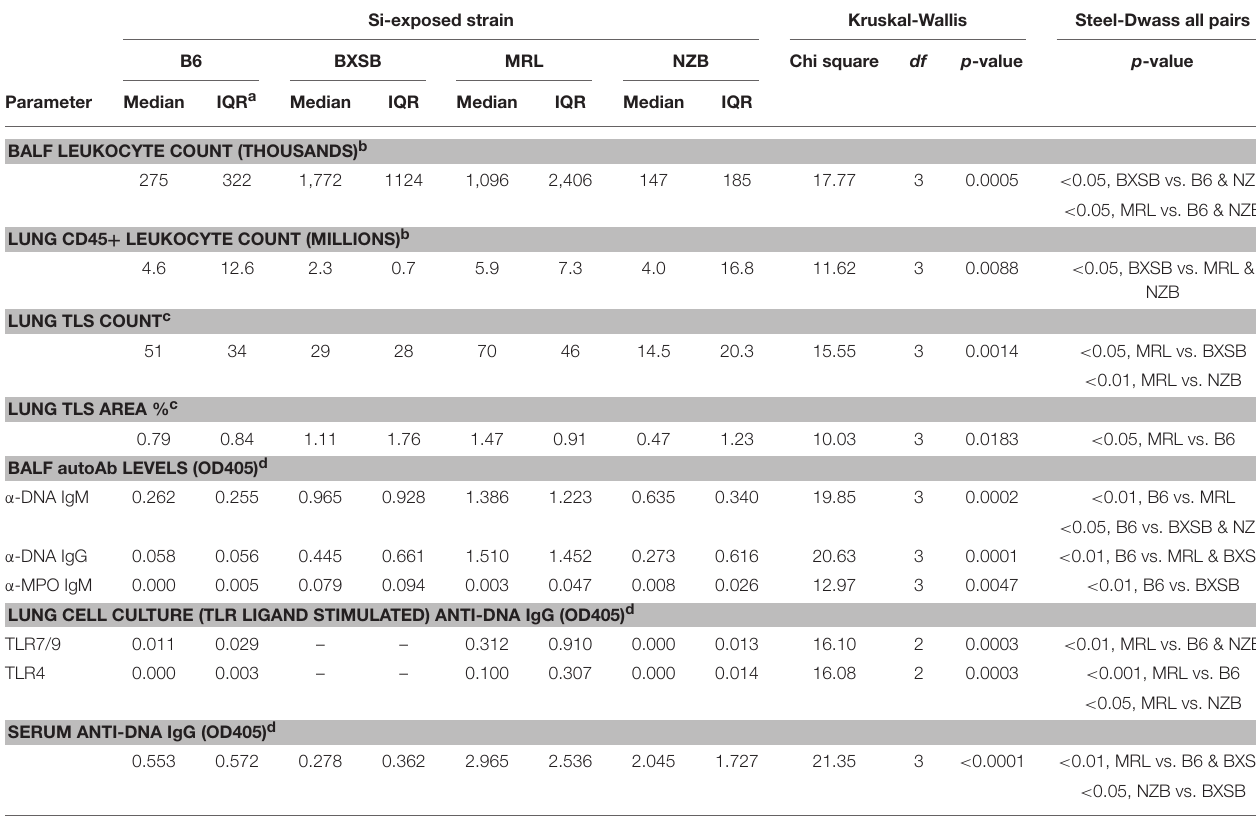
TABLE 1 | Differences between silica-exposed wildtype mice of diverse autoimmune genetic backgrounds. Si-exposed strain